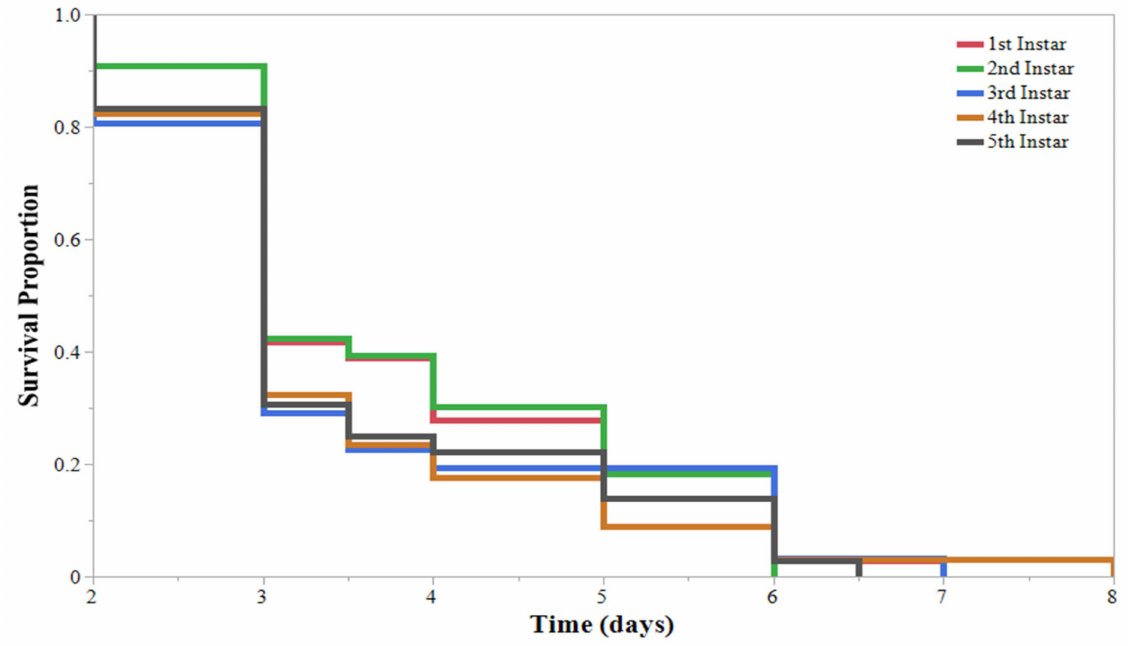
Figure 5. Kaplan–Meier survival curves for the 2nd infestation consisting of only 2nd instar larvae. Treatments are distinguished by the initial larval instar of the 1st infestation. There were no significant differences observed between survival curves. Log-rank test: χ 2 = 1.192, p = 0.879.